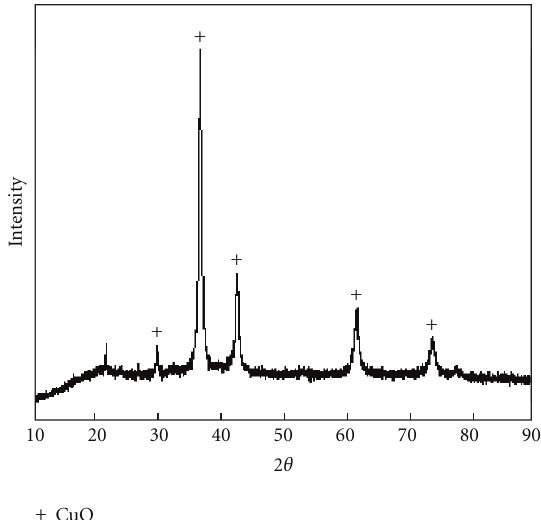
Figure 5: X-ray di ff raction patterns of particles when 0.5mol/dm 3 PGPPE with 0.3mol/dm 3 Cu(NO 3 ) 2 · 3H 2 O and 1.5 mol/dm 3 was